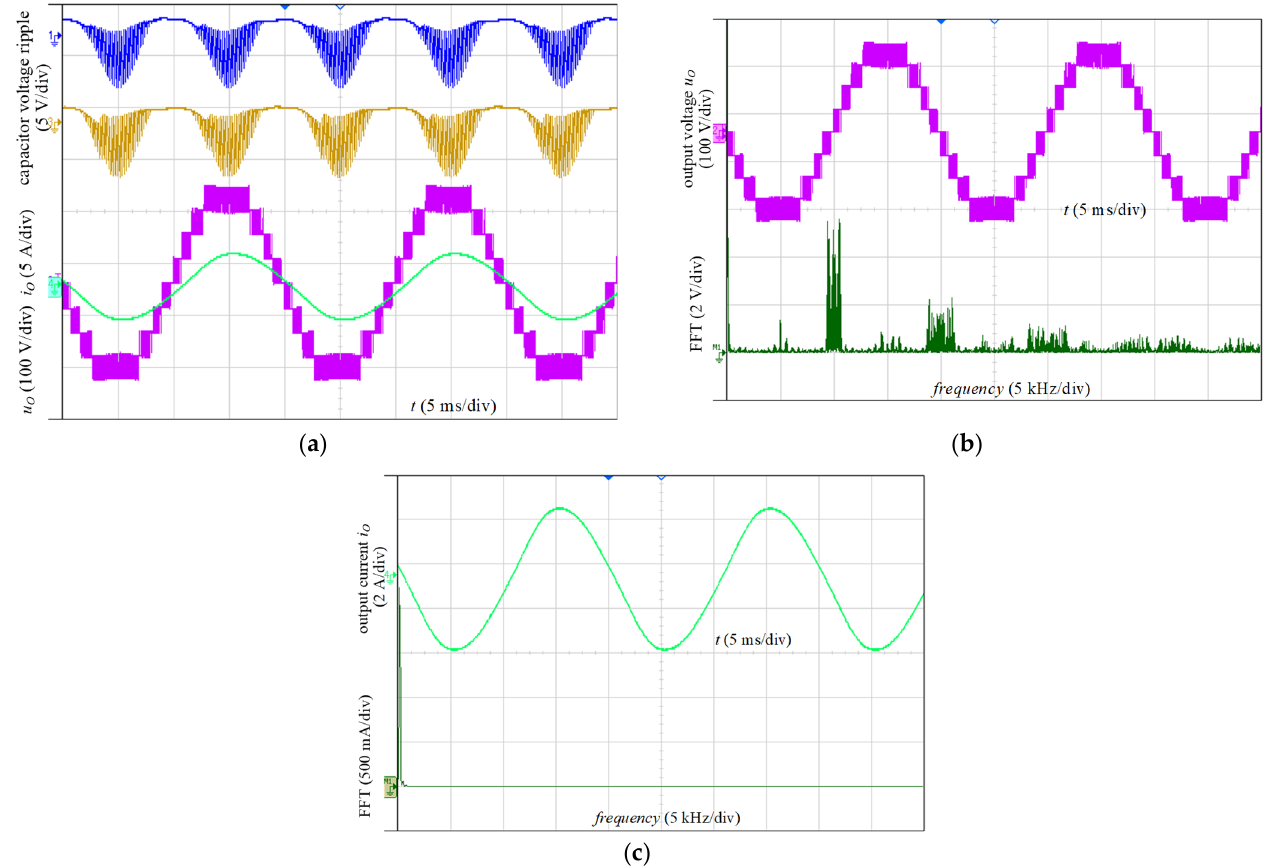
Figure 14. Experimental waveforms for an inductive load: ( a ) Waveforms of output voltage, output current, and capacitor voltage; ( b ) FFT analysis of output voltage; ( c ) FFT analysis of output current.